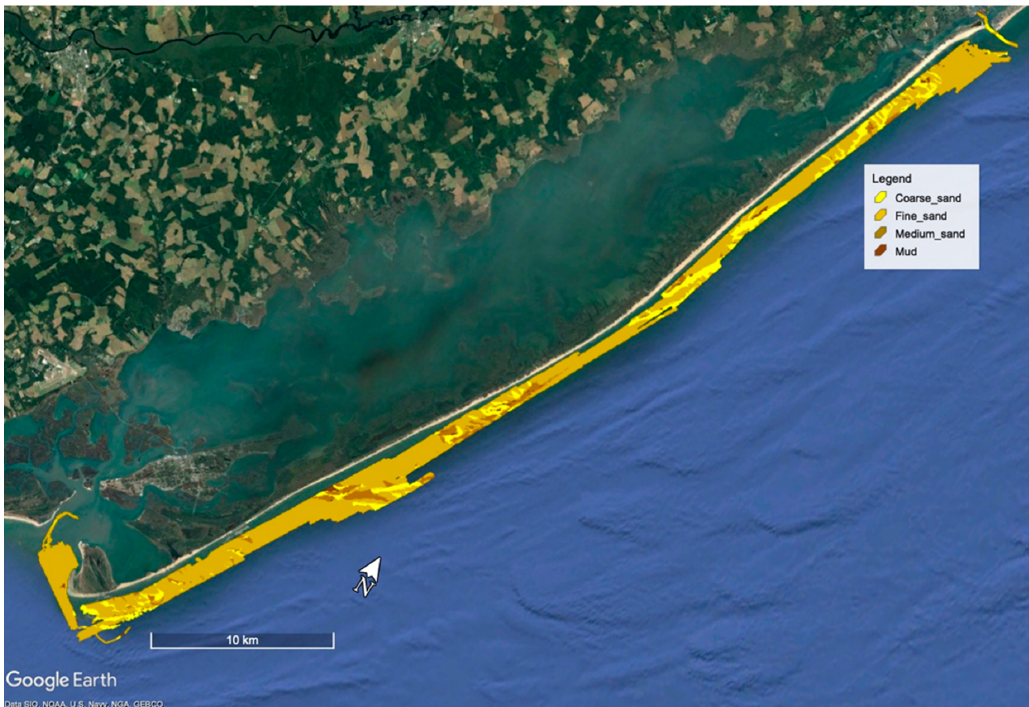
Figure 9. Sediment classification from 2014–2015 for the entire study area. Four sediment classes (coarse and medium sand, mud, and fine sand) were recognized and shaded with different colors. Mapping survey conducted 2014–2015.